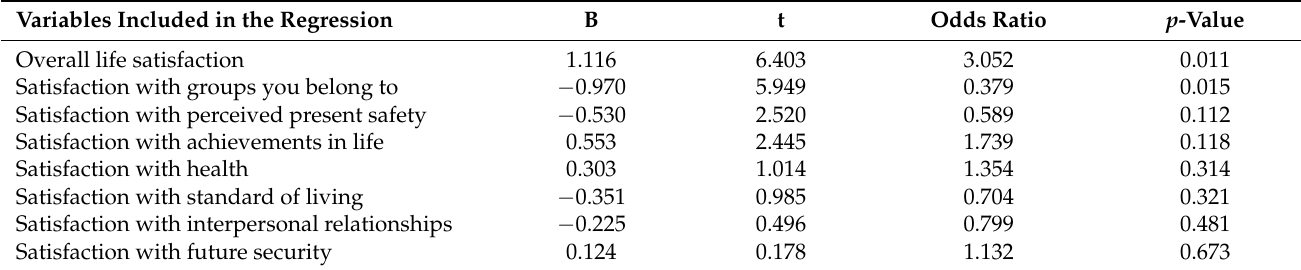
Table 7. Correlation of variables included in the binary logistic regression model with the variable having done or doing volunteer work as a dependent variable.